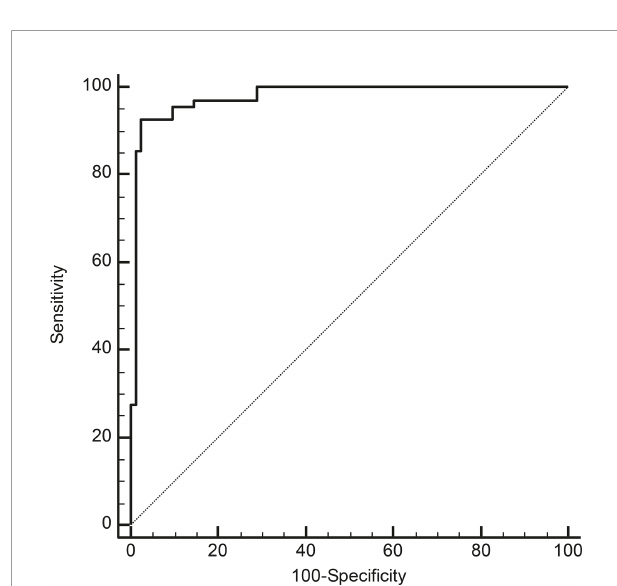
FIGURE 3 | ROC curve analyses to identify the most accurate cut-off for miR-375 serum levels for differentiating between cases with and without MTC (P < 0.01; AUC: